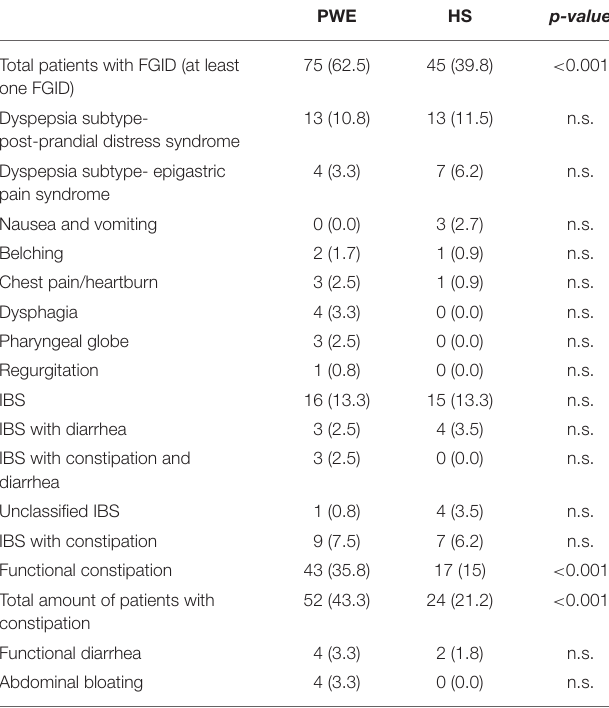
PWE HS p-value 75 (62.5)